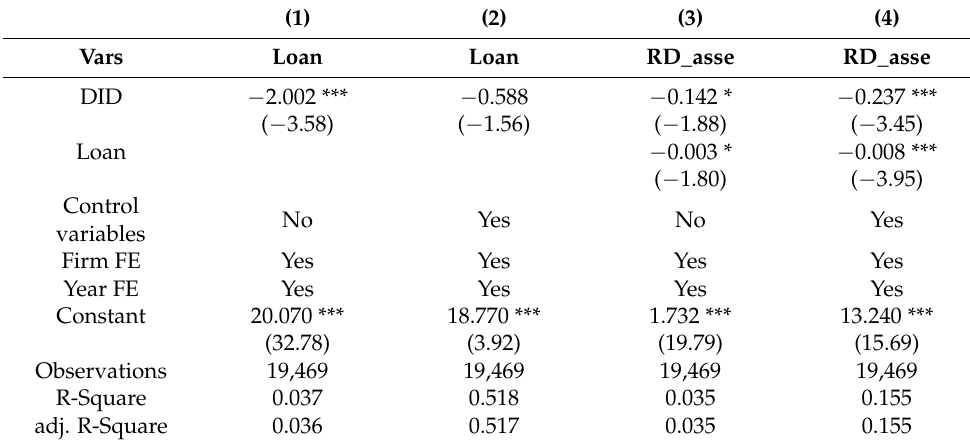
Table 4. Tests of intermediation effects of bank loans.